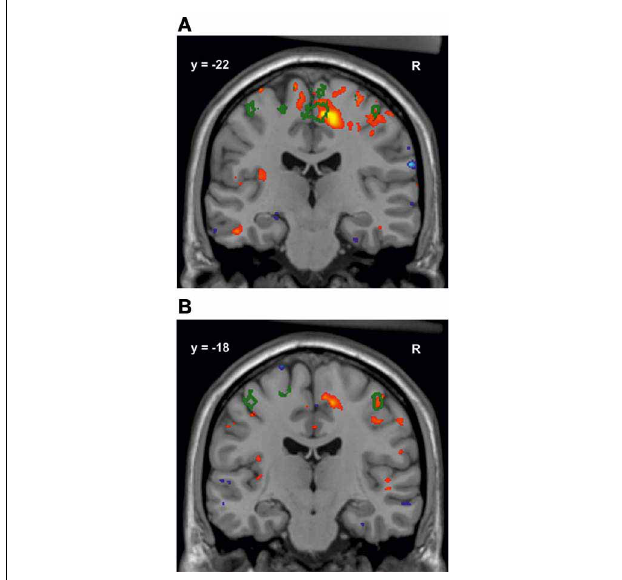
FIGURE 6 | Volume increase in M1 musicians compared to M2 musicians in the right primary motor cortex (red) with the contour of area 4a (green). (A) Shows a volume increase mainly in the foot region, but also the hand region (Geyer et al., 1996; B ).